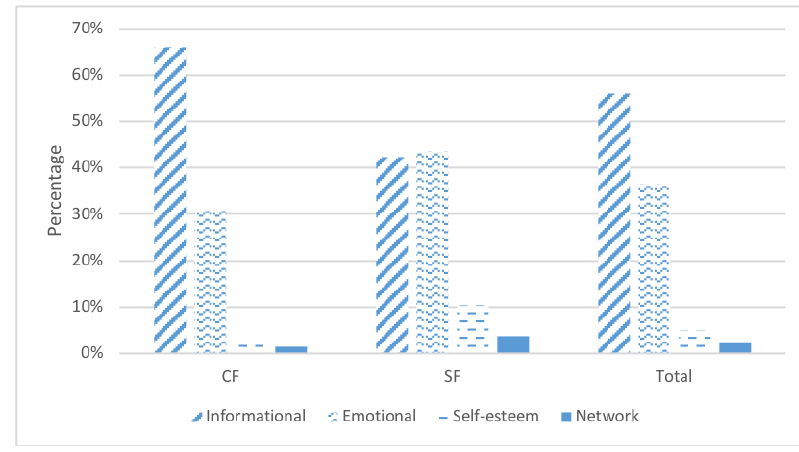
Figure 1. Type of support exchanged. Table 6. Type of support sought and provided by forum type.